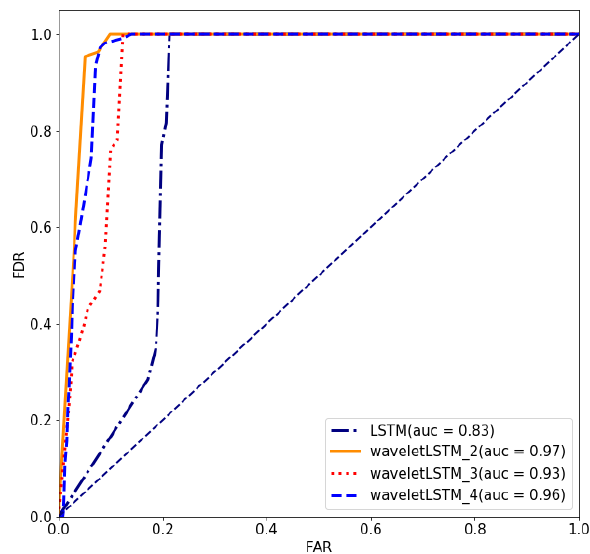
Figure 10. Effect of scale on detection performance of the proposed WaveletLSTM with different scales from 2 to